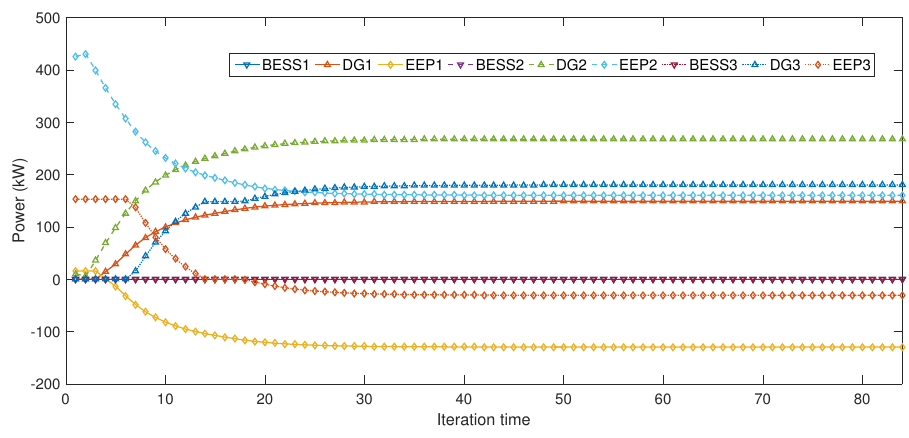
Figure 7. Evolution of the internal variables for the 26th time